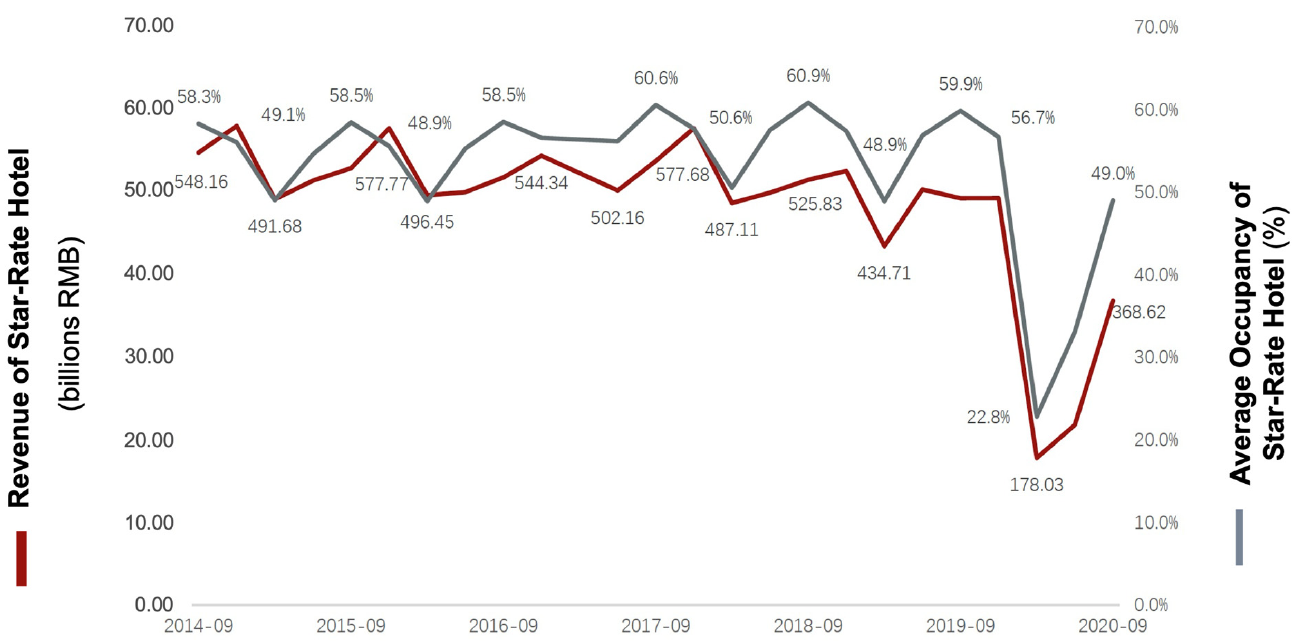
Figure 12. Revenue and average occupancy of star-rated hotels in China from 2014 Q3 to 2020 Q3.